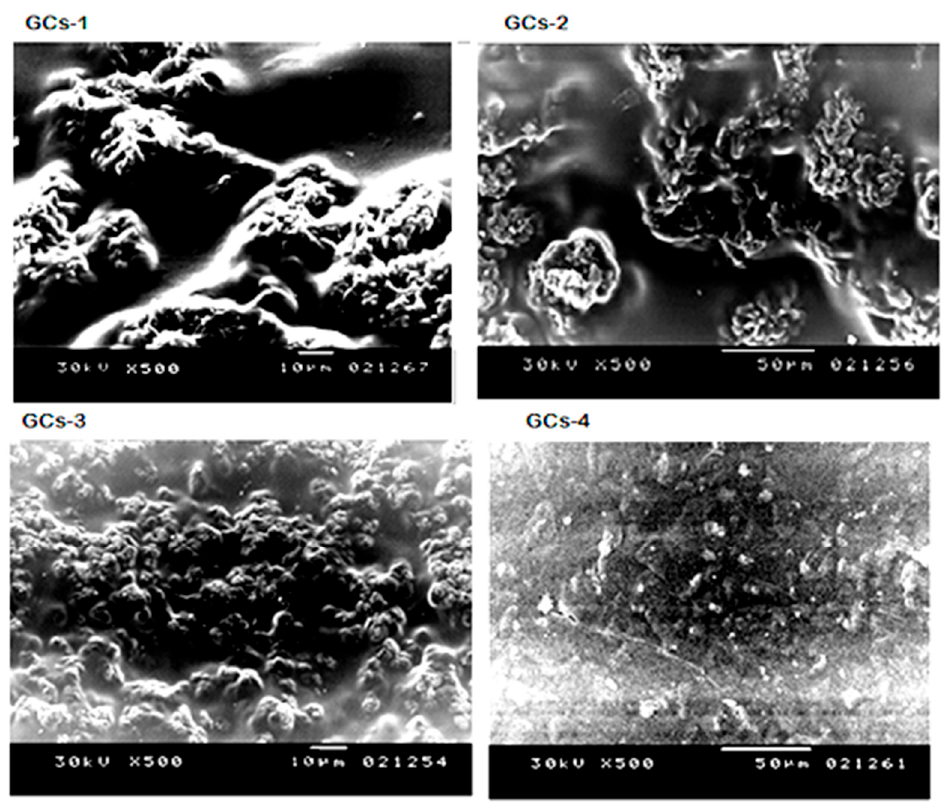
Figure 1. Scanning electron microscopy of G-chitosan hydrogels.